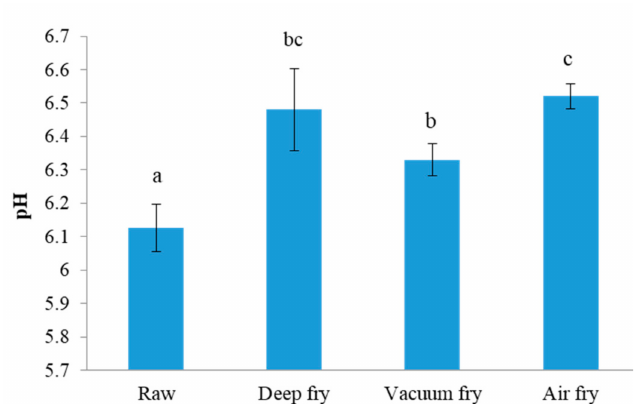
Figure 5. pH of chub mackerel ( Scomber japonicus ) in different frying methods. Data are presented as mean ± SD. Different superscript letters (a–c) show significantly different values according to Duncan’s test ( p < 0.05).